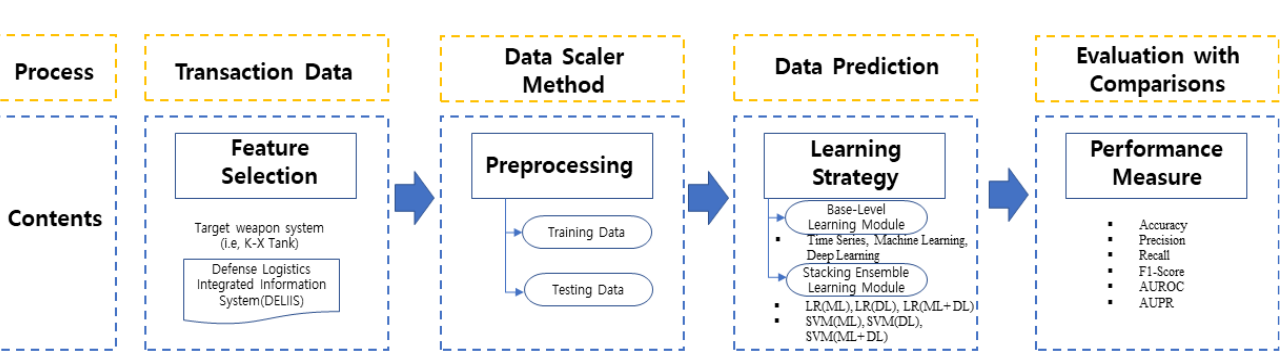
Figure 1. Overview of the demand forecasting process.